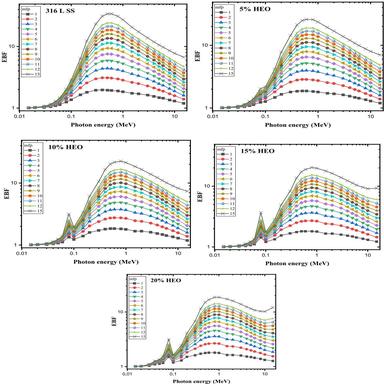
Variation of energy absorption build-up factors (EABF) against photon energy at different penetration depths for the HEO samples.